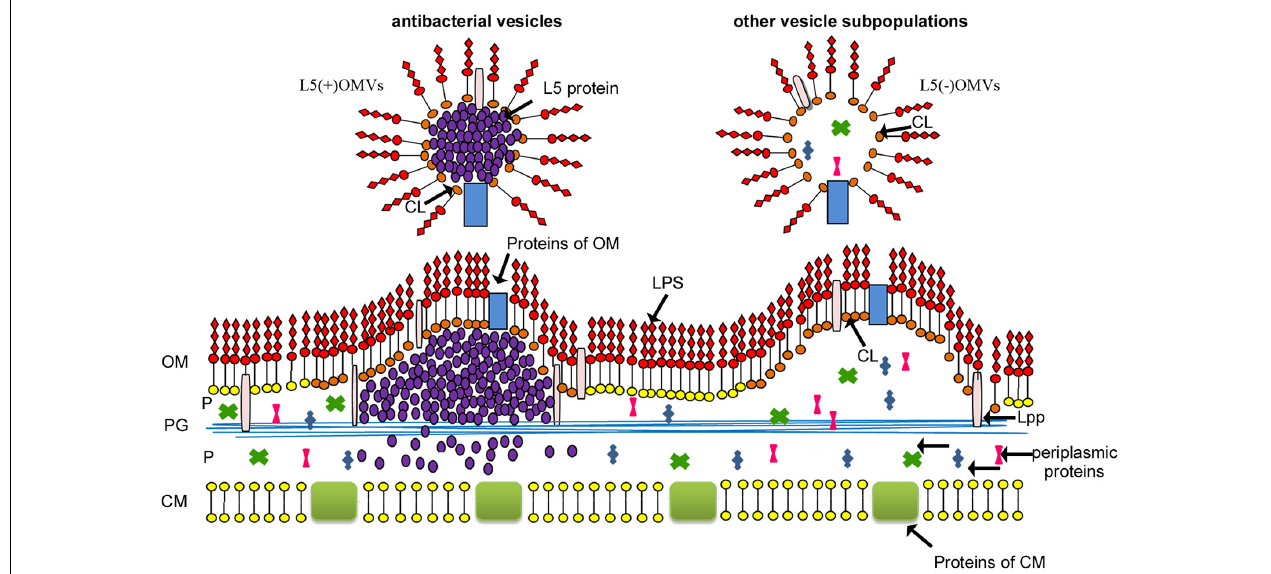
FIGURE 5 | Model of Lysobacter sp. XL1 vesicle biogenesis (Kudryakova et al., 2015) with modification. Lysobacter sp. XL1 forms several subpopulations of vesicles from OM loci enriched with CL. The hydrophilic head of cardiolipin carries two negative charges, and, due to their intermolecular repulsion, the rigidity of the OM can be disturbed in loci enriched with this phospholipid, which leads to the initiation of vesicle formation (Kudryakova et al., 2017). One of the vesicle subpopulations contains bacteriolytic enzyme L5. In the process of its topogenesis, this protein accumulates in the periplasm at the inner leaflet of the OM (Kudryakova et al., 2015) in the form of amyloid-like structures (Kudryakova et al., 2018). This may lead to a pressure on the cardiolipin-enriched inner leaflet of the OM (the destabilization locus) and contribute to the formation of a subpopulation of antibacterial vesicles containing protein L5. This vesicle subpopulation is a “bacterial bomb” for competitive bacteria and is involved in invasion expansion of ecological niches for Lysobacter sp. XL1. L5(+)OMVs, antibacterial subpopulation of vesicles containing protein L5; L5(–)OMVs, other subpopulations of vesicles; LPS, lipopolysaccharide; OM, outer membrane; P, periplasm; CM, cytoplasmic membrane; Lpp, lipoprotein; PG, peptidoglycan; CL, cardiolipin.